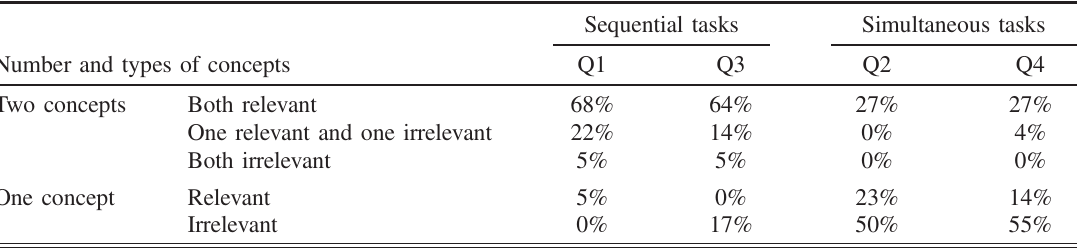
TABLE II. Number and types of concepts students identified for the sequential and simultaneous problems ( N ¼ 22